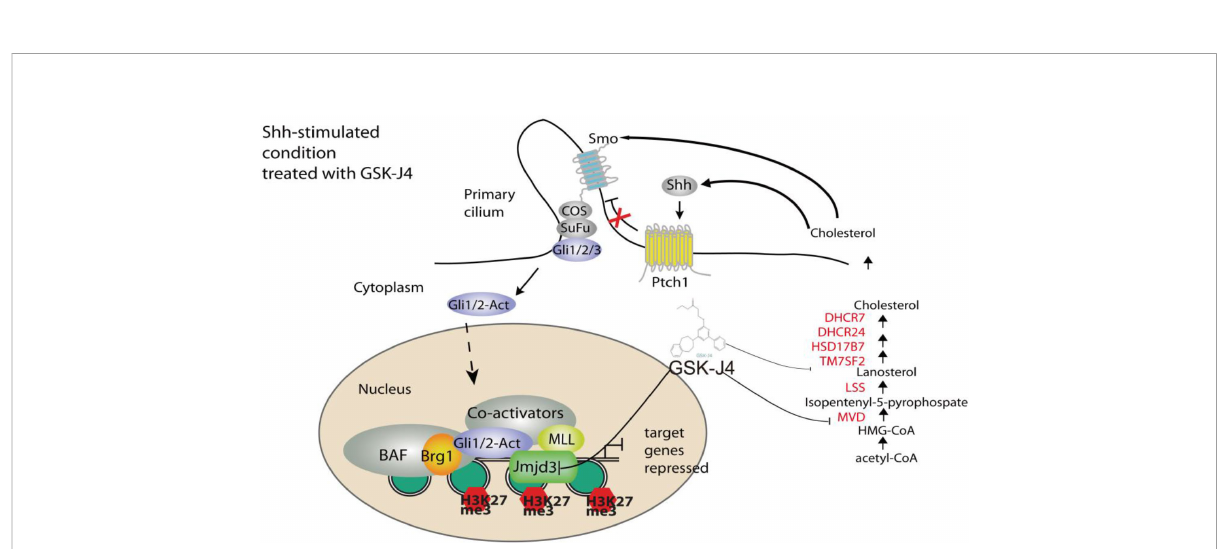
FIGURE 8 A model of Shh signaling regulated by small molecule compound GSK-J4 targeting the epigenetic switch. At basal condition, the processed transcriptional factor Gli3R represses Shh target gene and maintains high level of H3K27me3 on the regulatory region of target genes. In the presence of Shh, Gli3R is replaced with Gli1/2-Act, which recruits the coactivators Brg1 and Jmjd3. Decreases of H3K27me3 turn on the target gene expression. While acetyl-CoA is present, serial enzymes including MVD, DHCR7, and DHCR24, LSS convert acetyl-CoA to form cholesterol. With the treatment of GSK-J4, activity of Jmjd3 is inhibited and H3K27me3 increases, which leads to impaired Shh signaling and cholesterol biosynthesis.